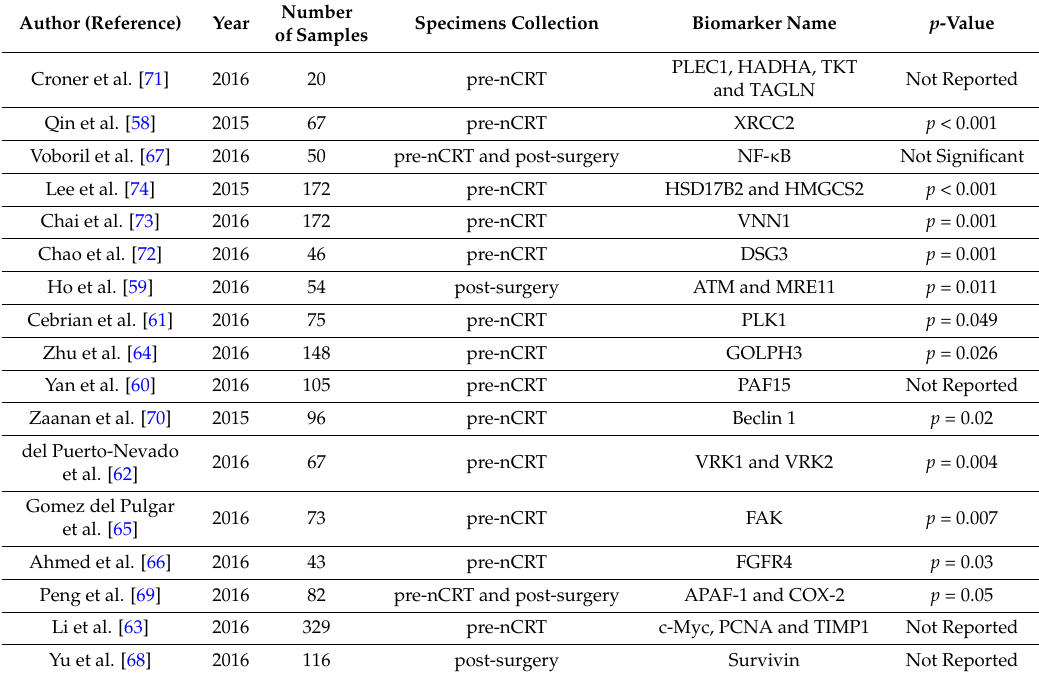
Table 1. Tissue-based protein biomarkers for nCRT response in rectal